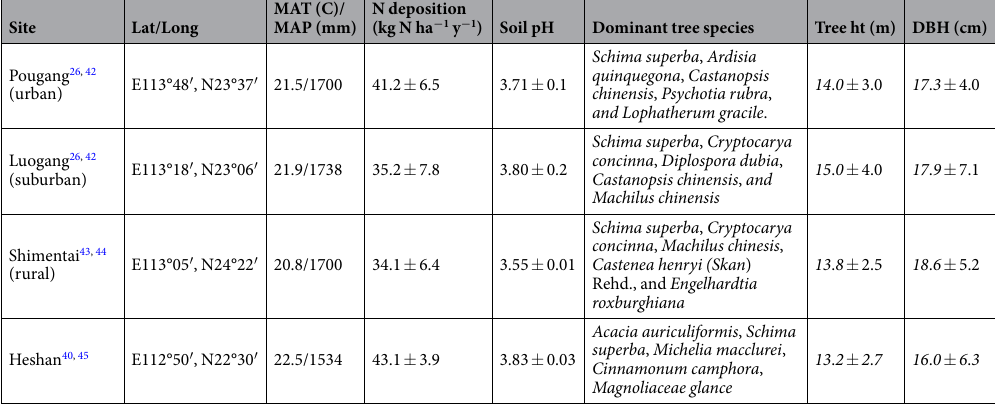
Table 1. Site characteristics. Values are mean ± 1 standard